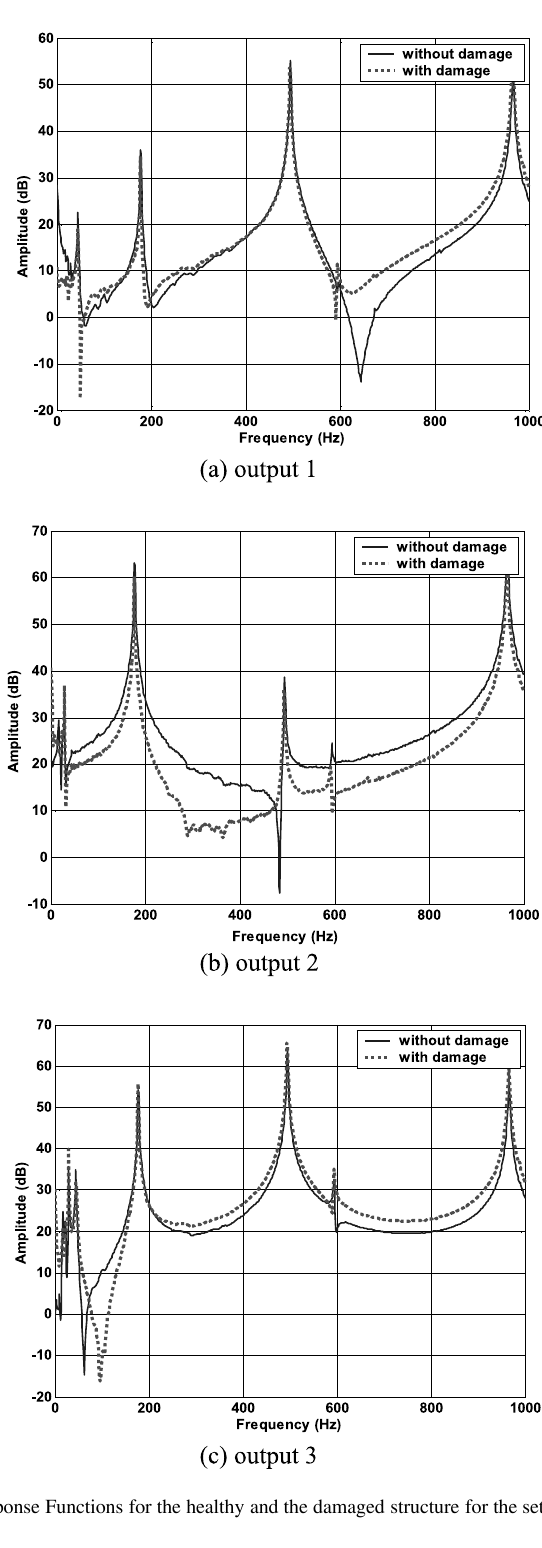
Fig. 6. Experimental Frequency Response Functions for the healthy and the damaged structure for the set-up shown in Fig. 5 [dB ref 1m/s 2